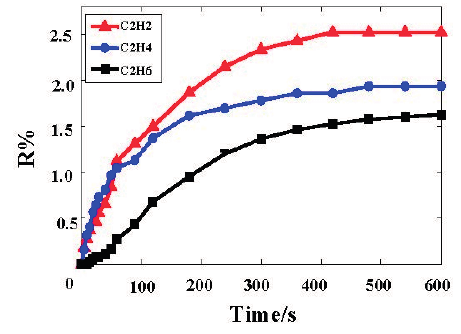
Figure 3. Ni-CNT sensor response to 10 µL/L C 2 H 2 , C 2 H 4 , and C 2 H 6